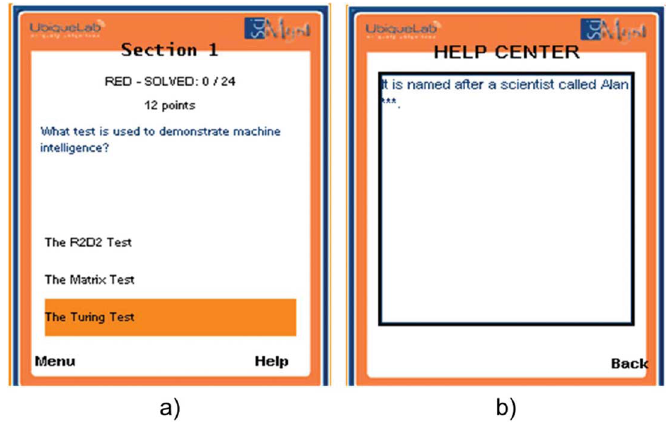
Figure 2. An enigma (a) and a related additional hint (b) in